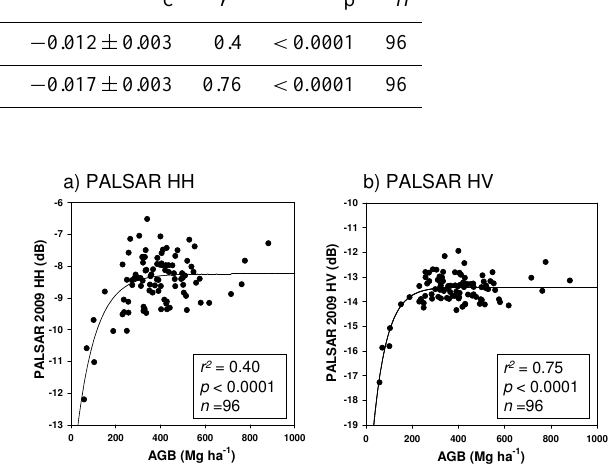
Fig. 6. ALOS PALSAR backscatter in a) HH and b) HV polarisa- tions is plotted against AGB for 96 field plots (including 75 × 1ha sections of long